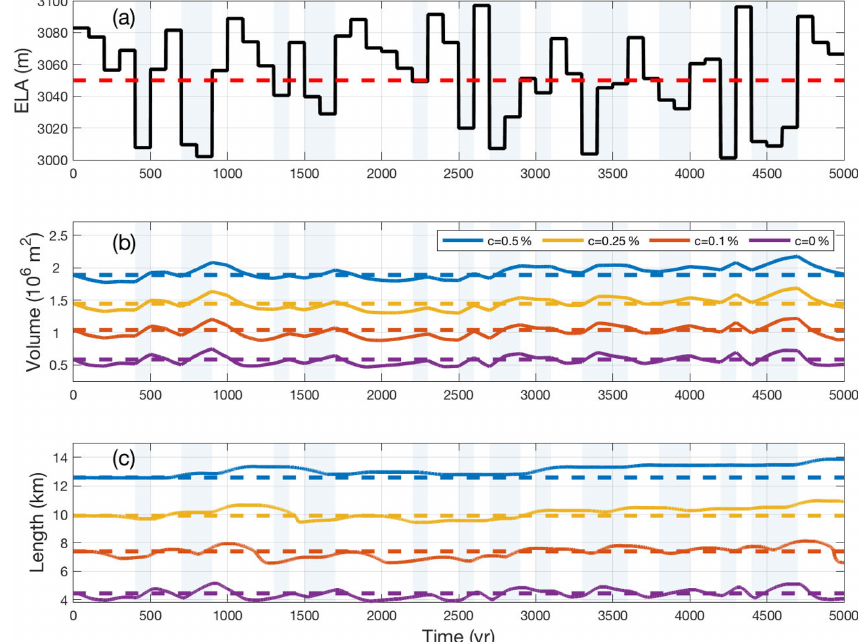
Figure 6. Random climate forcing (a) and the corresponding transient volume response (b) and transient length response (c) for glaciers of different debris concentrations. The dashed lines represent (a) the mean value climate of ELA = 3050m and the corresponding steady-state (b) volume and (c) length. The light blue background shading represents temporal periods during which the climate forcing is colder than the mean